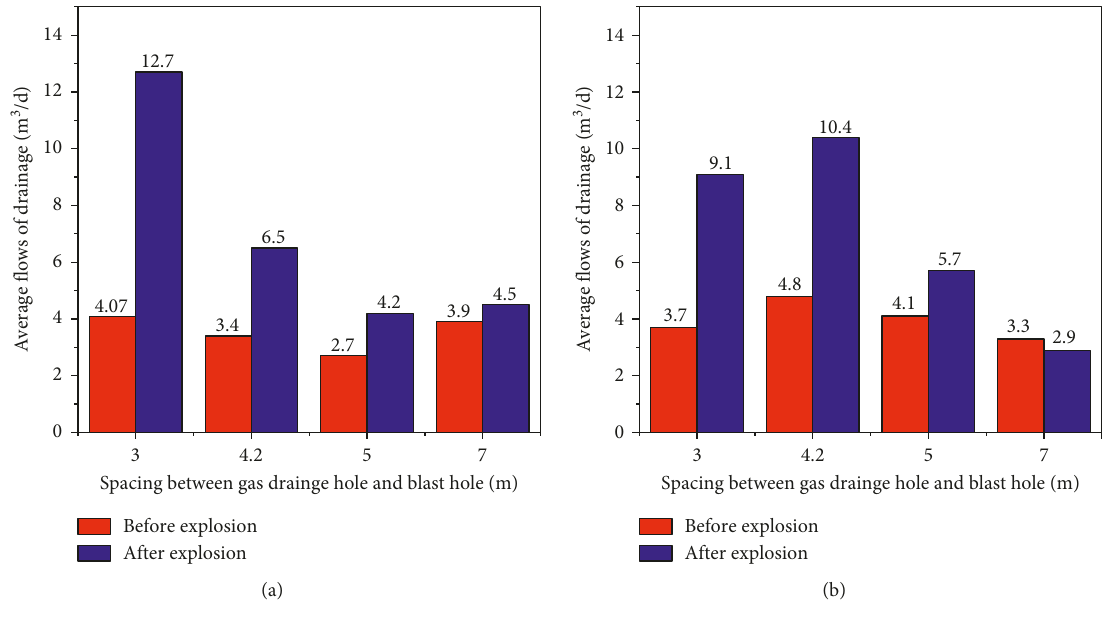
Figure 16: Average flows of gas drainage: (a) group 1; (b) group